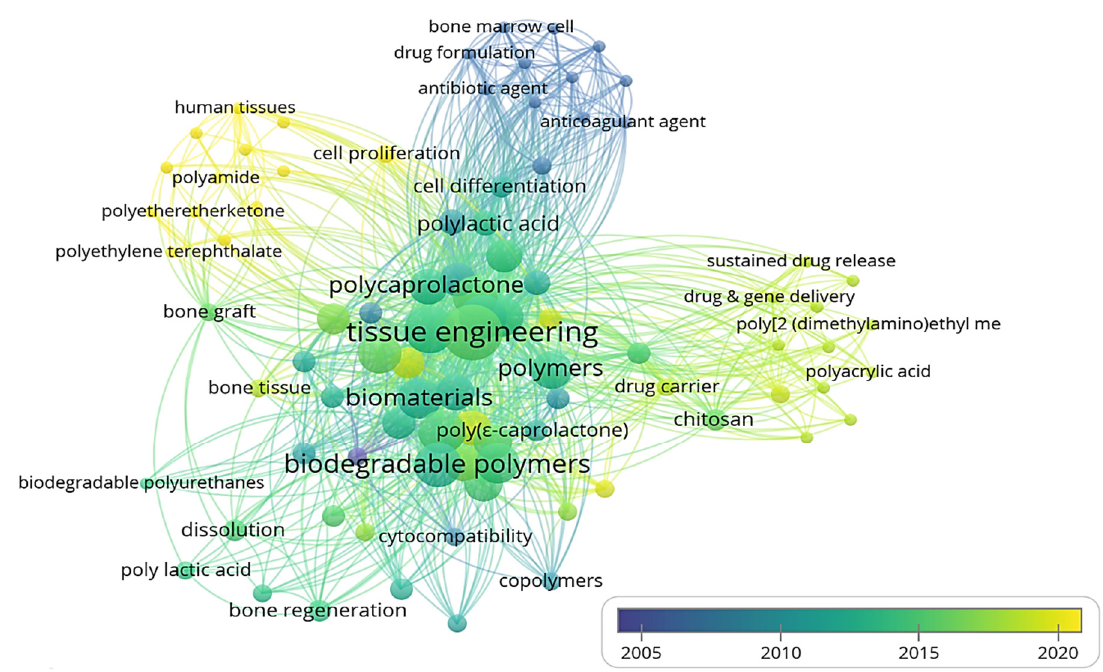
Figure 24. Bibliometric analysis of the utilization of biodegradable and other natural polymeric biomaterials in hard tissue engineering applications.